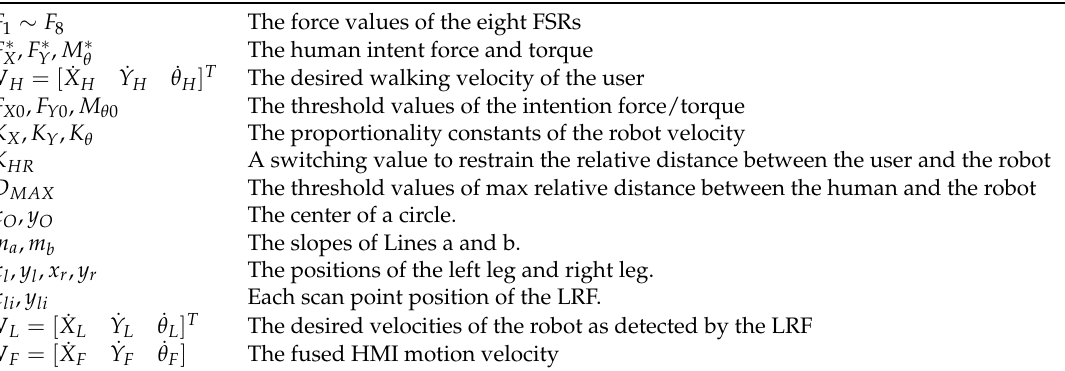
Table 1. The symbols in our paper. FSR, force-sensing resistor; LRF, laser range finder; HMI, human motion